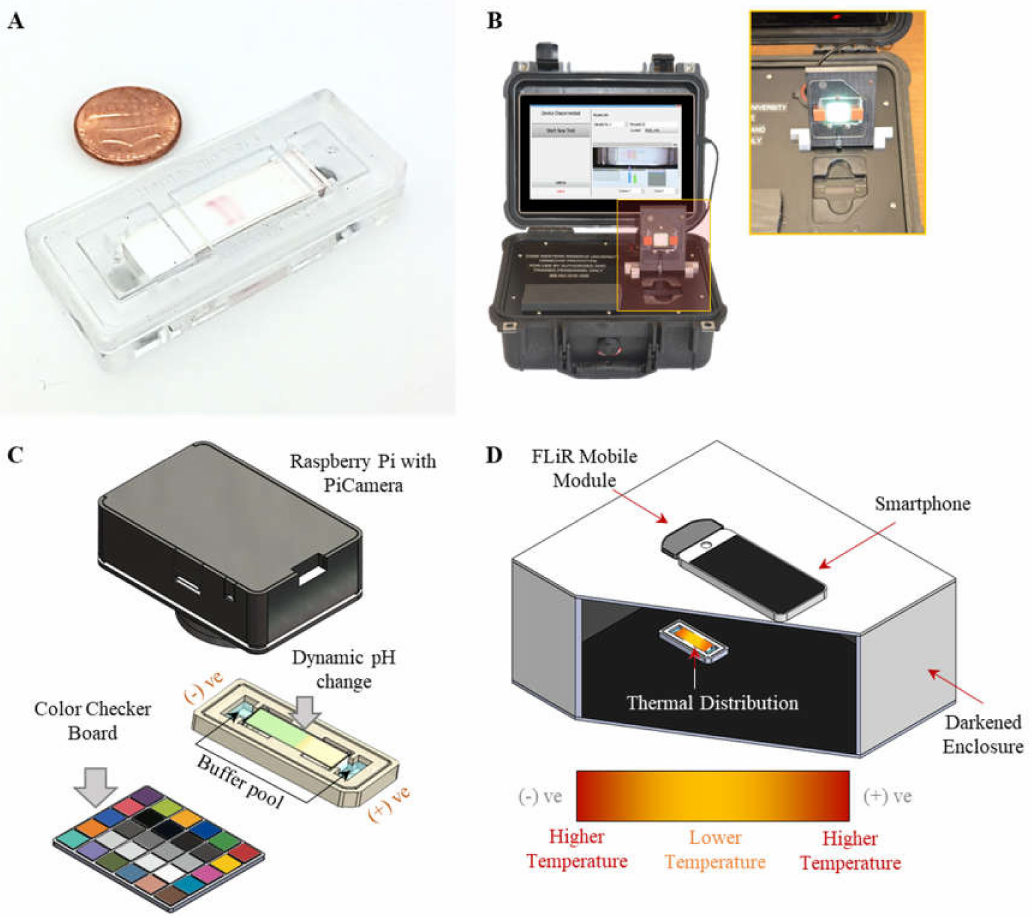
Figure 1. System setup for dynamic run-time pH and temperature-change tracking in the HemeChip cartridge. ( A ) An injection molded mass-produced HemeChip cartridge. ( B ) The HemeChip reader contains the hardware, software, and a user interface to guide the user through the test and display test result at the end of the test. ( C ) Illustration of the dynamic pH monitoring system on CA paper mounted on the HemeChip cartridge. ( D ) Illustration of the dynamic temperature-monitoring system on CA